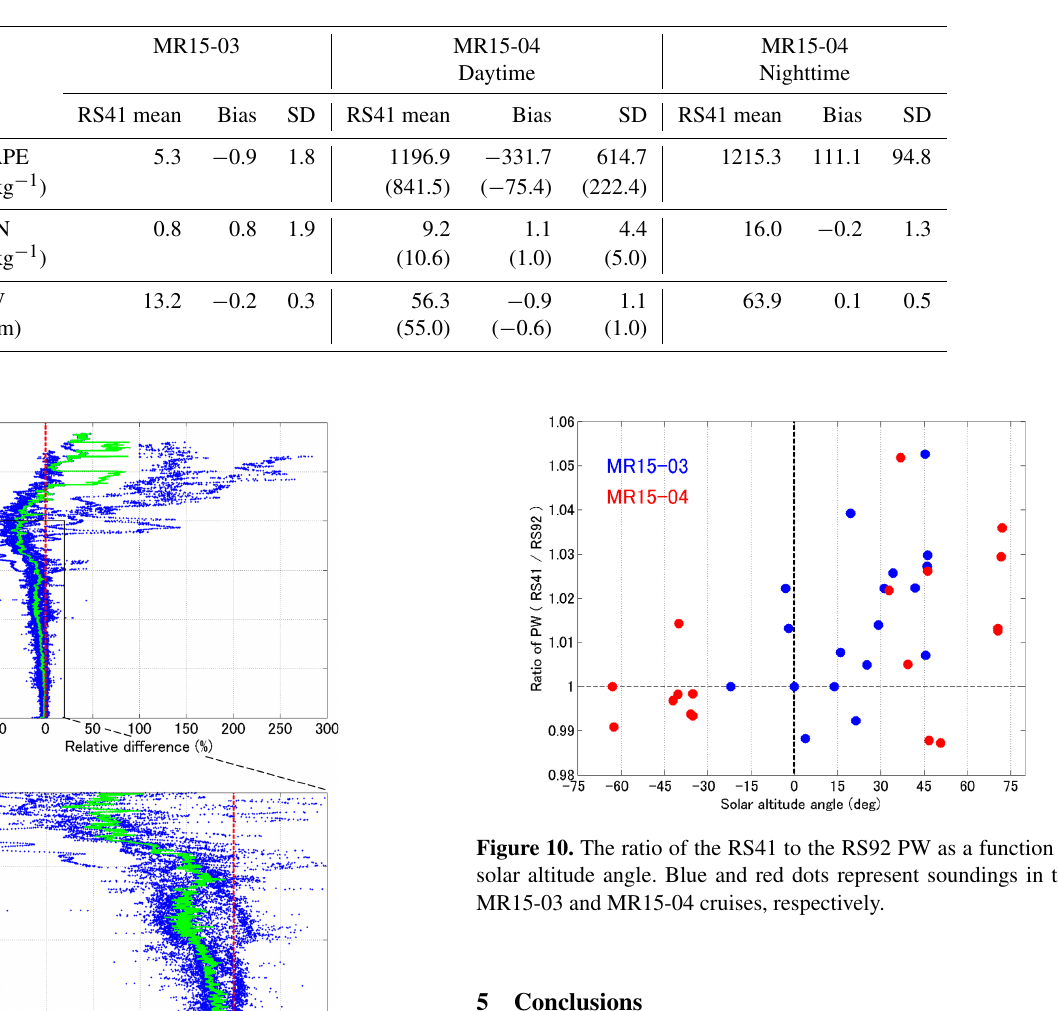
Table 4. Biases and standard deviations of CAPE, CIN, and PW between the RS92 and RS41 radiosondes. The bias is the mean of RS92– RS41 differences. Values in parentheses are the statistics without the two outliers shown in Fig. 7b–c (flight nos. 22 and 23).